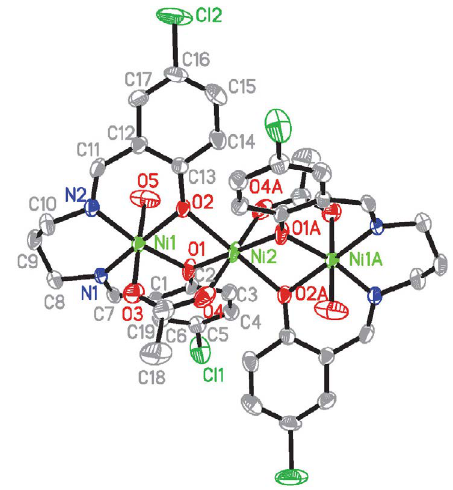
Fig. 1. Molecular structure of the complex. Displacement ellipsoids are drawn at the 30% probability level and H atoms are omitted for clarity. Atoms labeled with the suffix A or unlabeled are related to the symmetry position 1 – x , – y , – z .